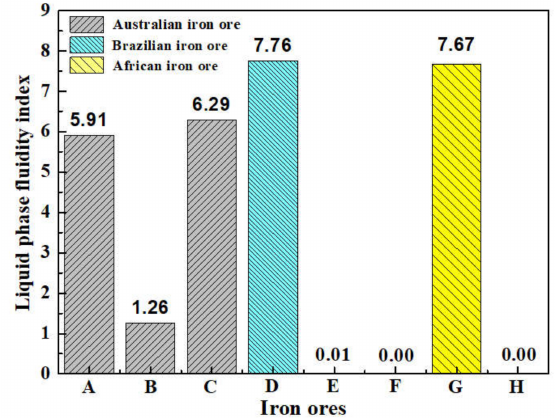
Figure 5. Liquid phase fluidity index of iron ores in various alumina